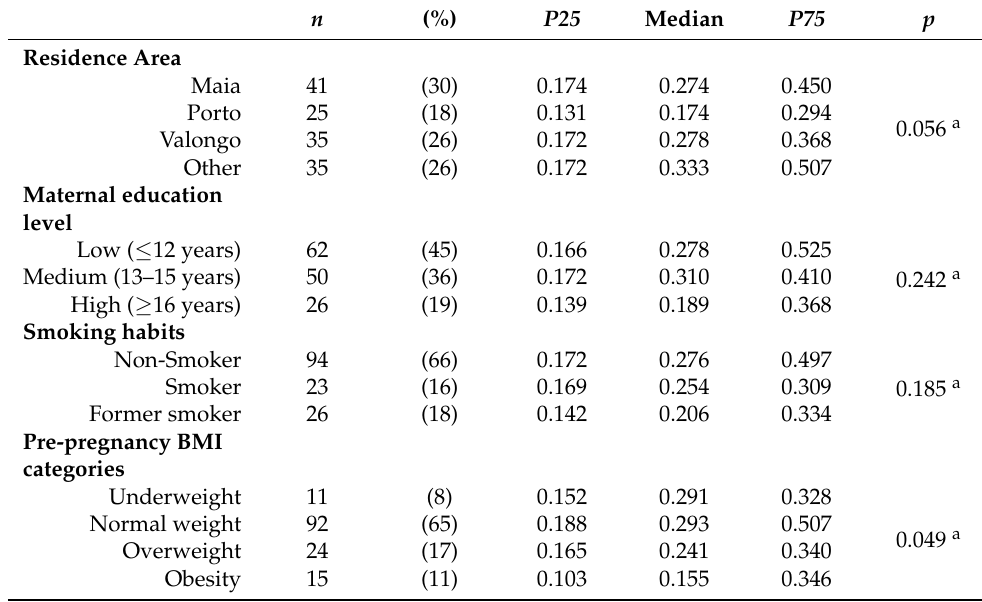
Table 2. Urinary levels of 3-PBA ( µ g/g) by participant characteristics.